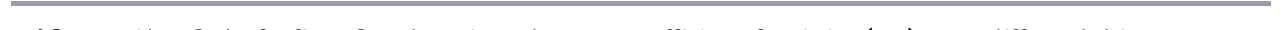
Table 3 . Incidental take for five selected species and average coefficient of variation (CV) across different habitat types: BCR = Bird Conservation Region (Canada); Pop = abundance estimate based on this study (total area of agricultural habitat types considered * estimated population density); BBS = Breeding Bird Survey population estimate per BCR in Canada (includes also non-agricultural habitat); M = total number of young (egg and prefledging stage) killed directly by mechanical yg_lost_net farming operations; M = number of additional young (egg and prefledging stage) killed by mechanical operations that would yg_add be expected to live in the absence of these